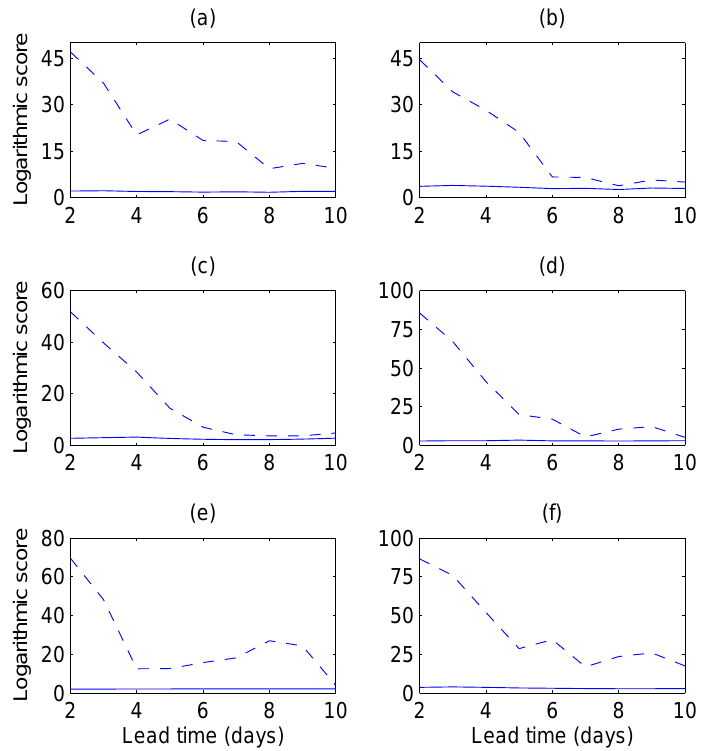
Fig. 9. Comparison between post-processed (blue solid line) and raw (dashed blue line) ensemble forecasts according to the logarithmic